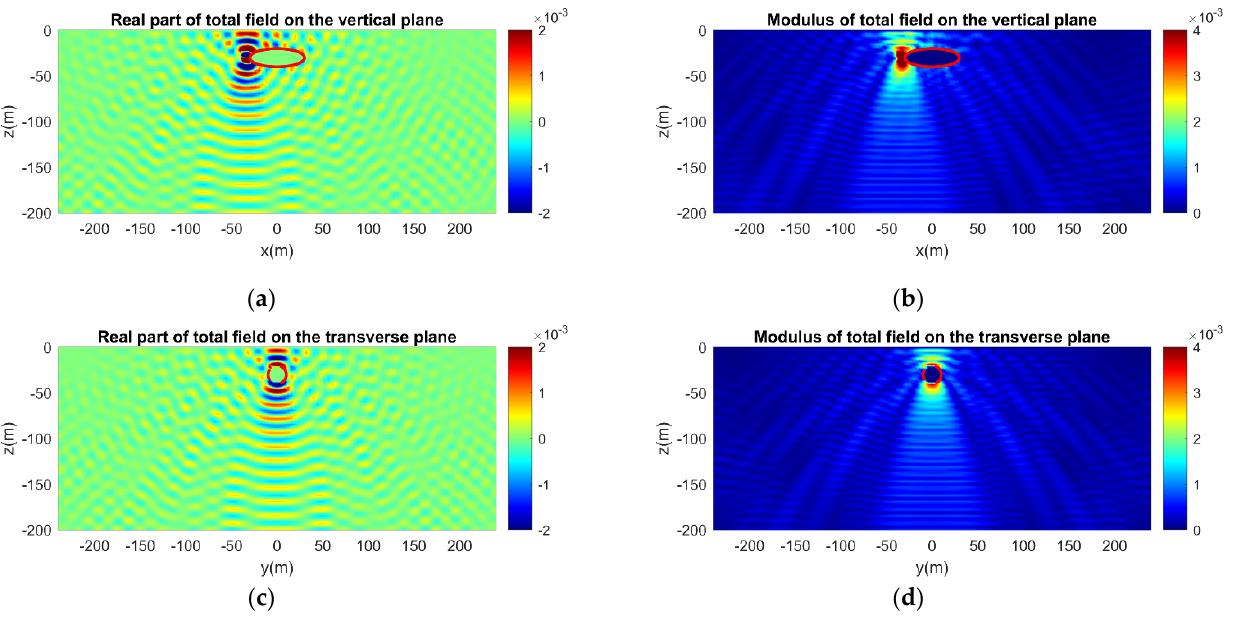
Figure 12. Same as Figures 10 and 11, but for a vertical dipole source. The axis of the dipole is parallel